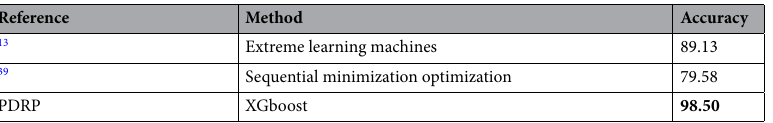
Table 3. Comparative results on binary class problem. The best accuracy is in bold. We converted partial response and full response to a single class “response”; and no response and stable disease to a single class “no response”.